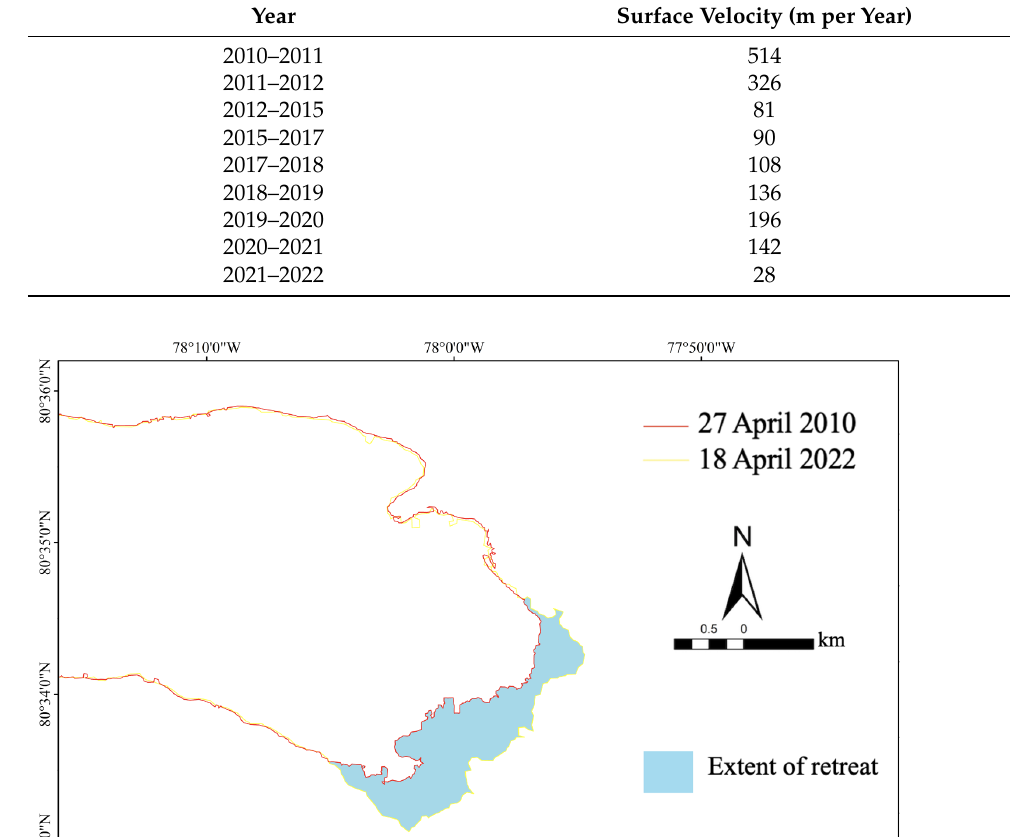
Figure 9. Ice fronts of the d’Iberville glacier extracted from the HH-polarised NRCS from 2010 to 2022. Table 3. Average retreating surface velocities of the d’Iberville glacier ice front estimated from the experimental results shown in Figure 9.